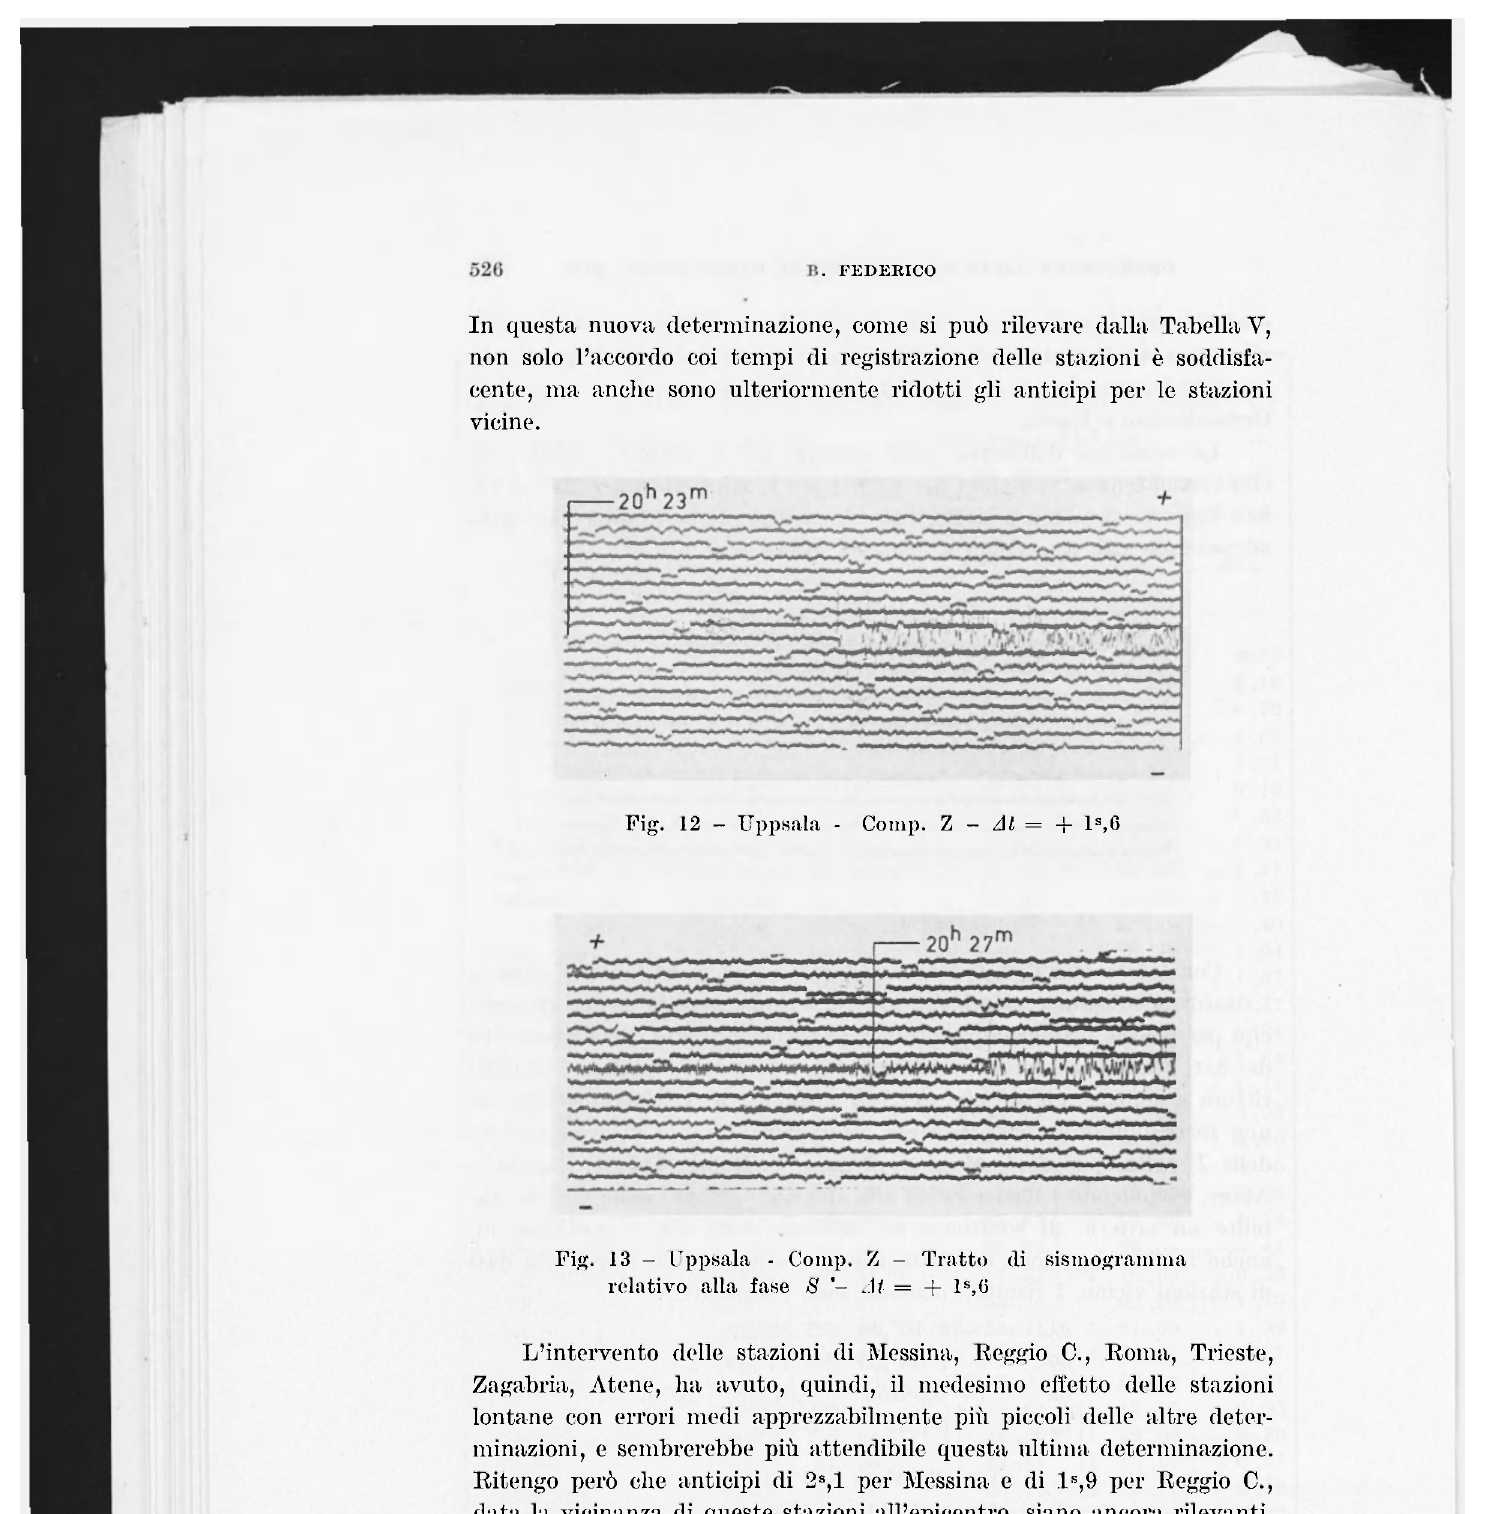
Fig. 13 — Uppsala - Comp. Z - Tratto di sismogramma relativo alla fase S - At = + l s